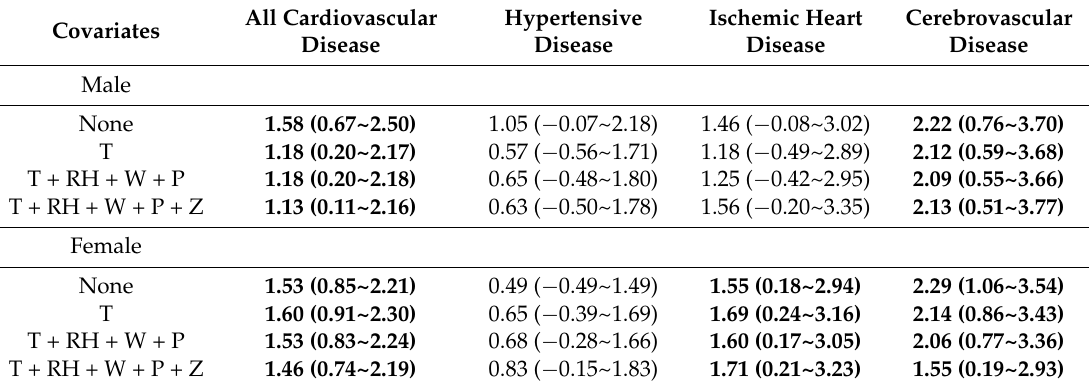
Table 6. Percent increase (mean and 95% CI) of the elderly ER admissions for 1 ˝ C increase of DTR before and after adjustment for covariates a,b